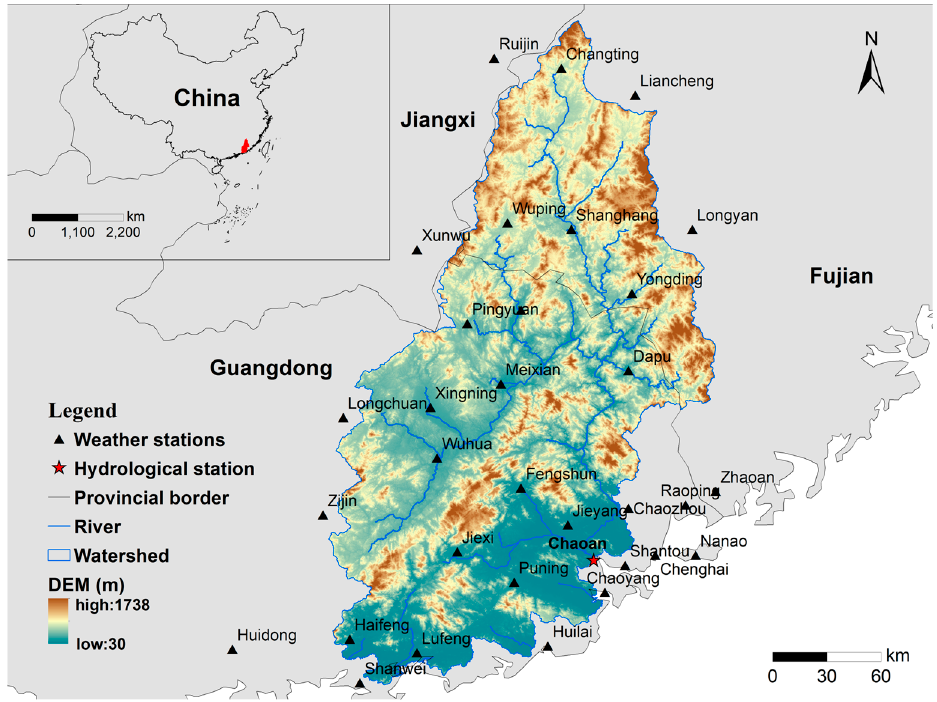
Figure 1. Location and distribution of meteorological and hydrological stations in Hanjiang River Basin, China.